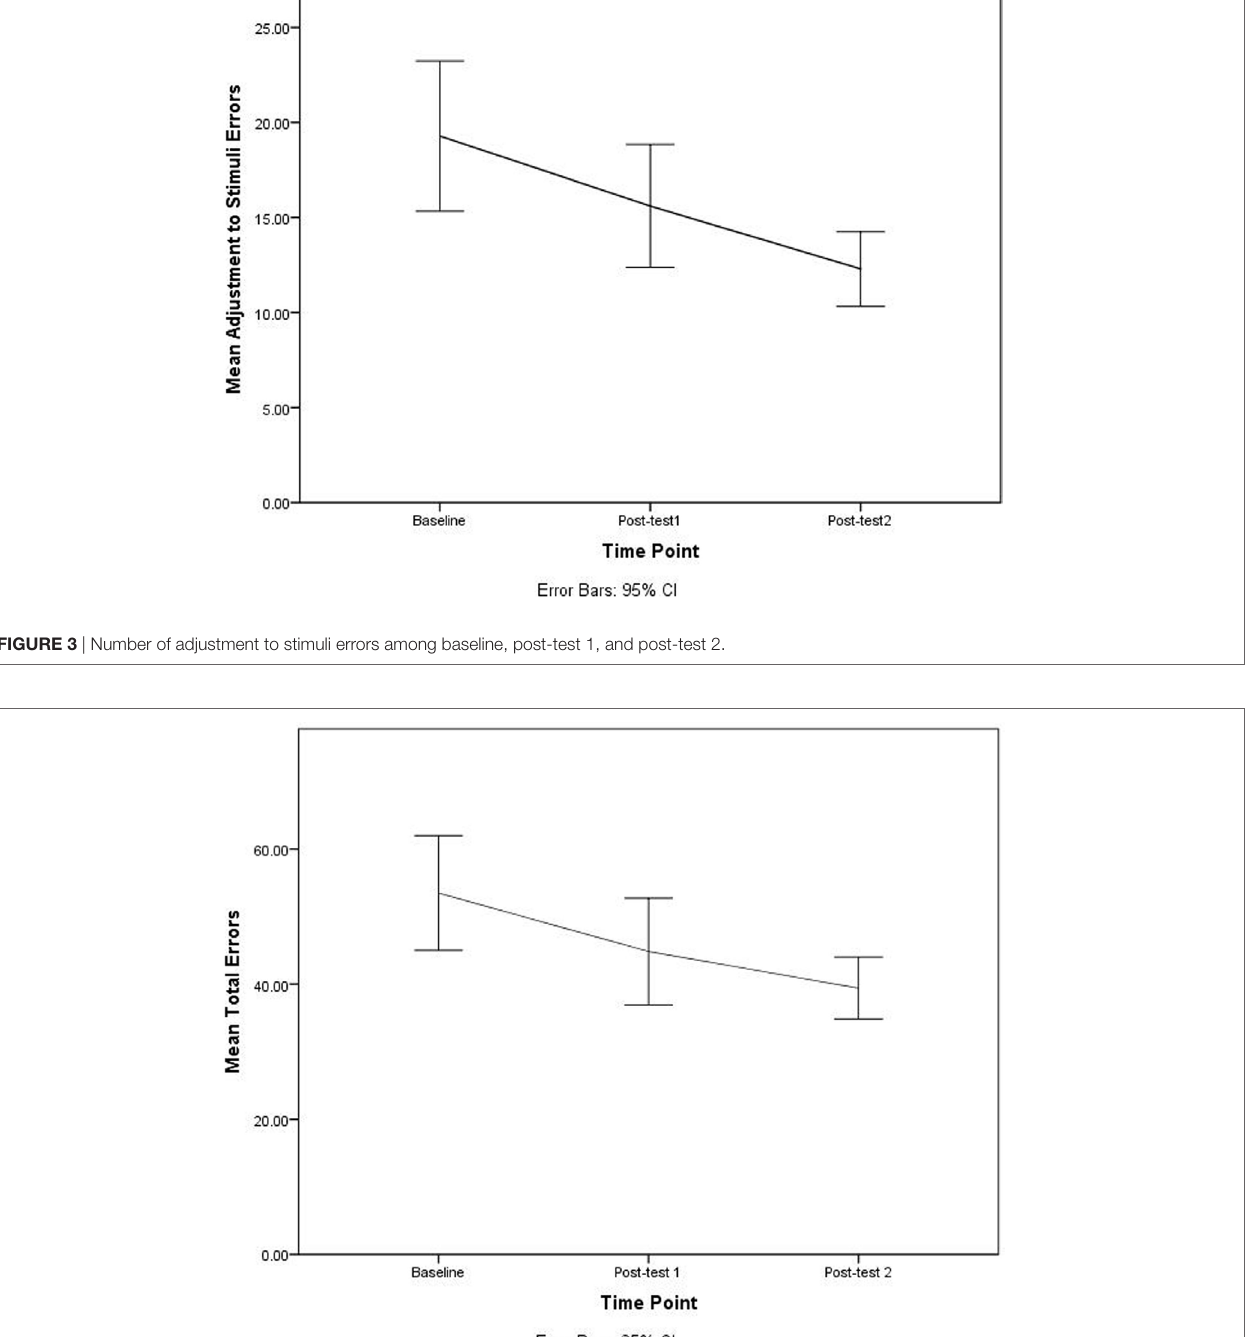
FigUre 4 | Total number of errors among baseline, post-test 1, and post-test